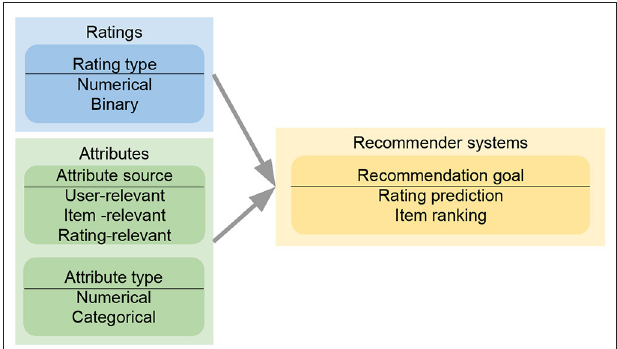
FIGURE 4 | Model design flow of an attribute-aware collaborative filtering-based recommender system. When reading ratings and attributes for a proposed approach, we have to consider the sources and the types of attributes or ratings, which could affect the recommendation goals and model designs. The evaluation of a proposed recommender system depends heavily on the chosen recommendation